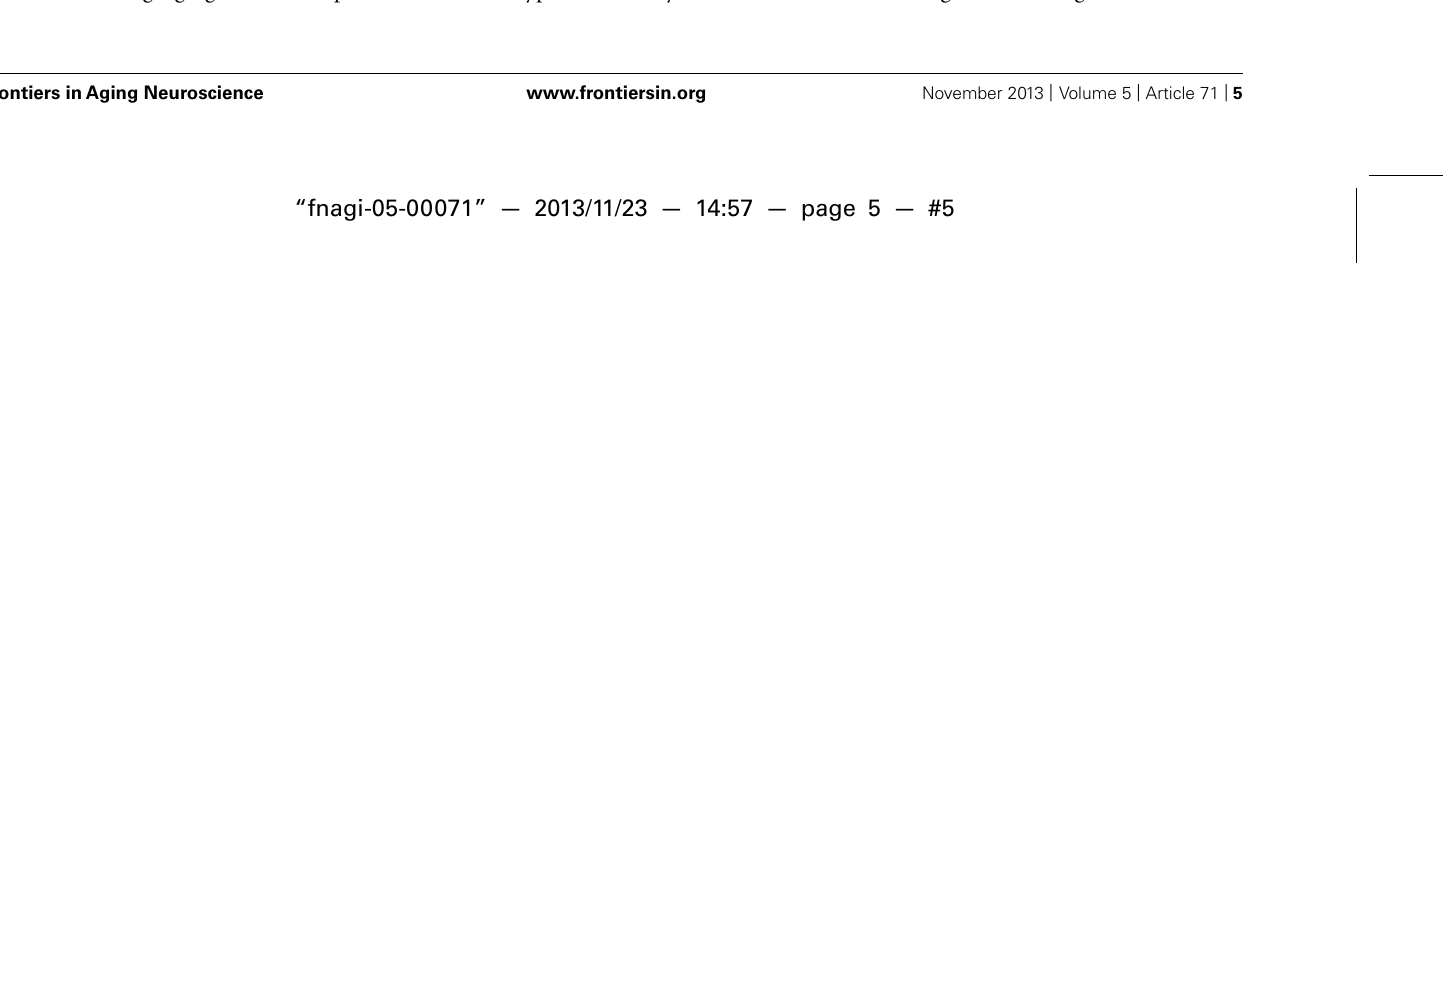
and cingulum (B) , occipital (C) , and parietal (D) .The regions were numbered according to the anatomical automatic labeling template. Diffusion kurtosis is